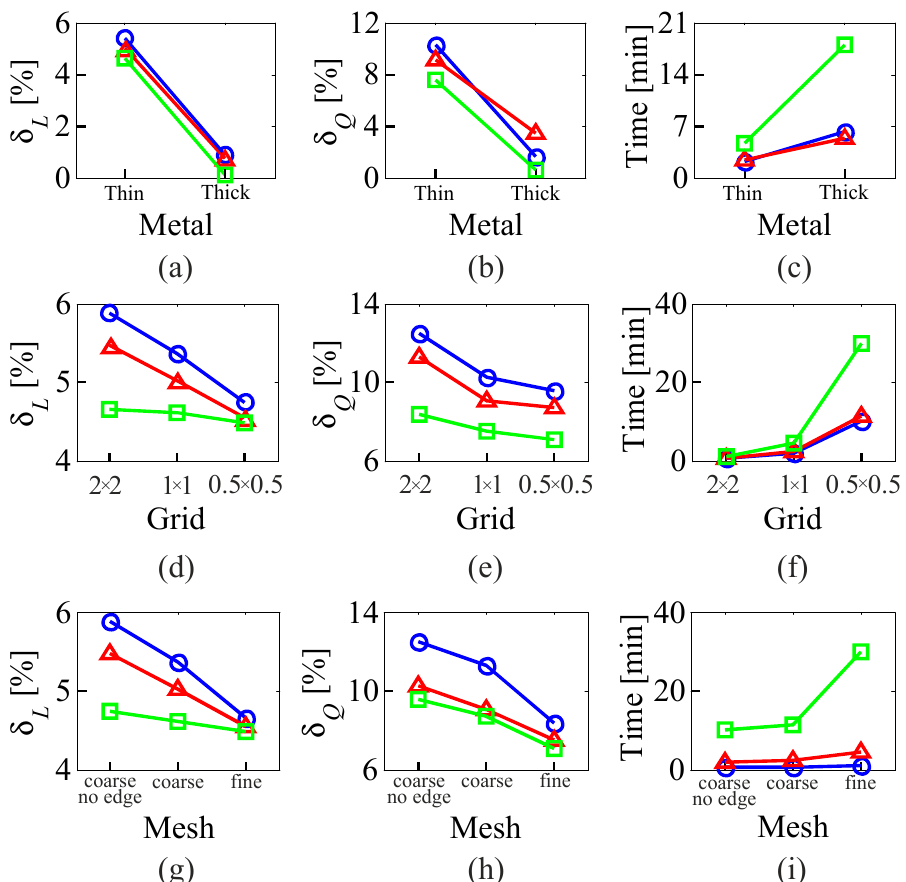
Figure 2. Examples of EM models of graduated complexity of a rectangular 4-turn, 1-layer coil. From left to right: coarse model without edge meshing, routed on a 2 × 2 grid; coarse model with edge are presented in Figure 3. The inspection of Figure 3 reveals the independent metal model, grid, and meshing effects for different EM model settings.